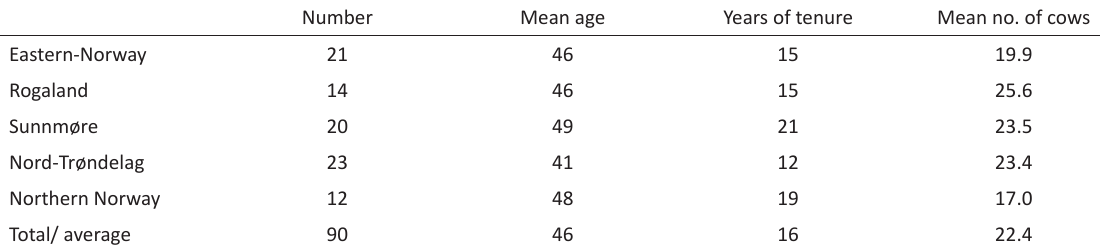
Table 1. Summary statistics for the 90 farmers we interviewed Number Mean age Years of tenure Mean no. of